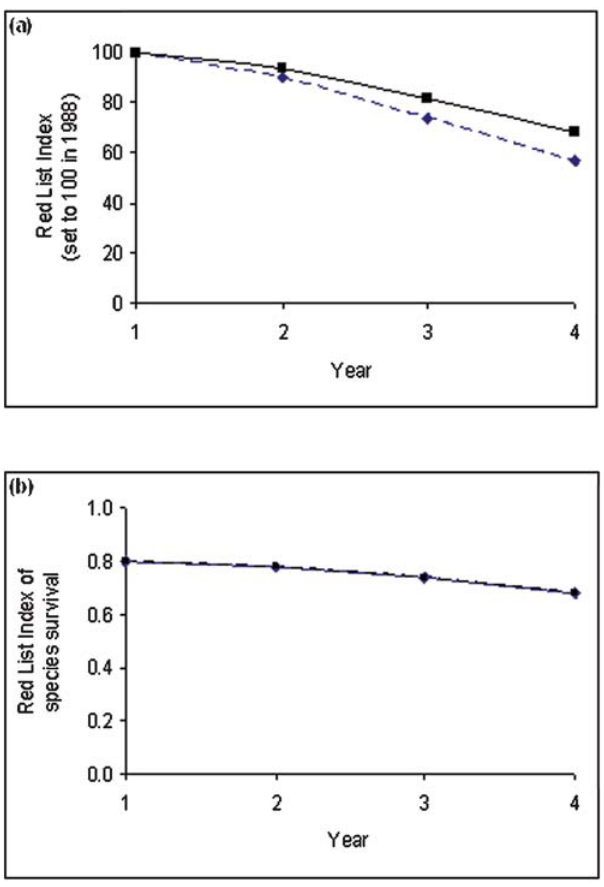
Figure 2. RLI using (A) the original formulation; and (B) the new formulation for the same hypothetical set of 10 species as in Figure 1c and g. The dotted line represents the RLI that would be calculated if five Near Threatened species had been misclassified as Vulnerable in year 1 owing to poor knowledge, and if this error was not corrected until year 4. The original formulation produces an RLI that is substantially lower in value than reality because it propagates errors resulting from in- complete knowledge in earlier assessments. The new formulation does not suffer from this effect.